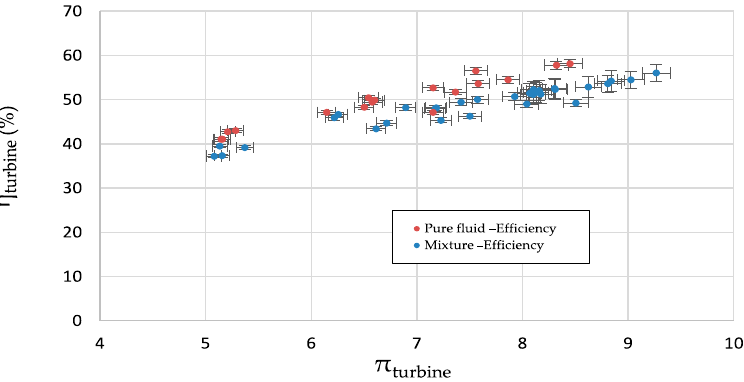
Figure 4. The turbine’s overall electrical e ffi ciency according to the pressure ratio. 331